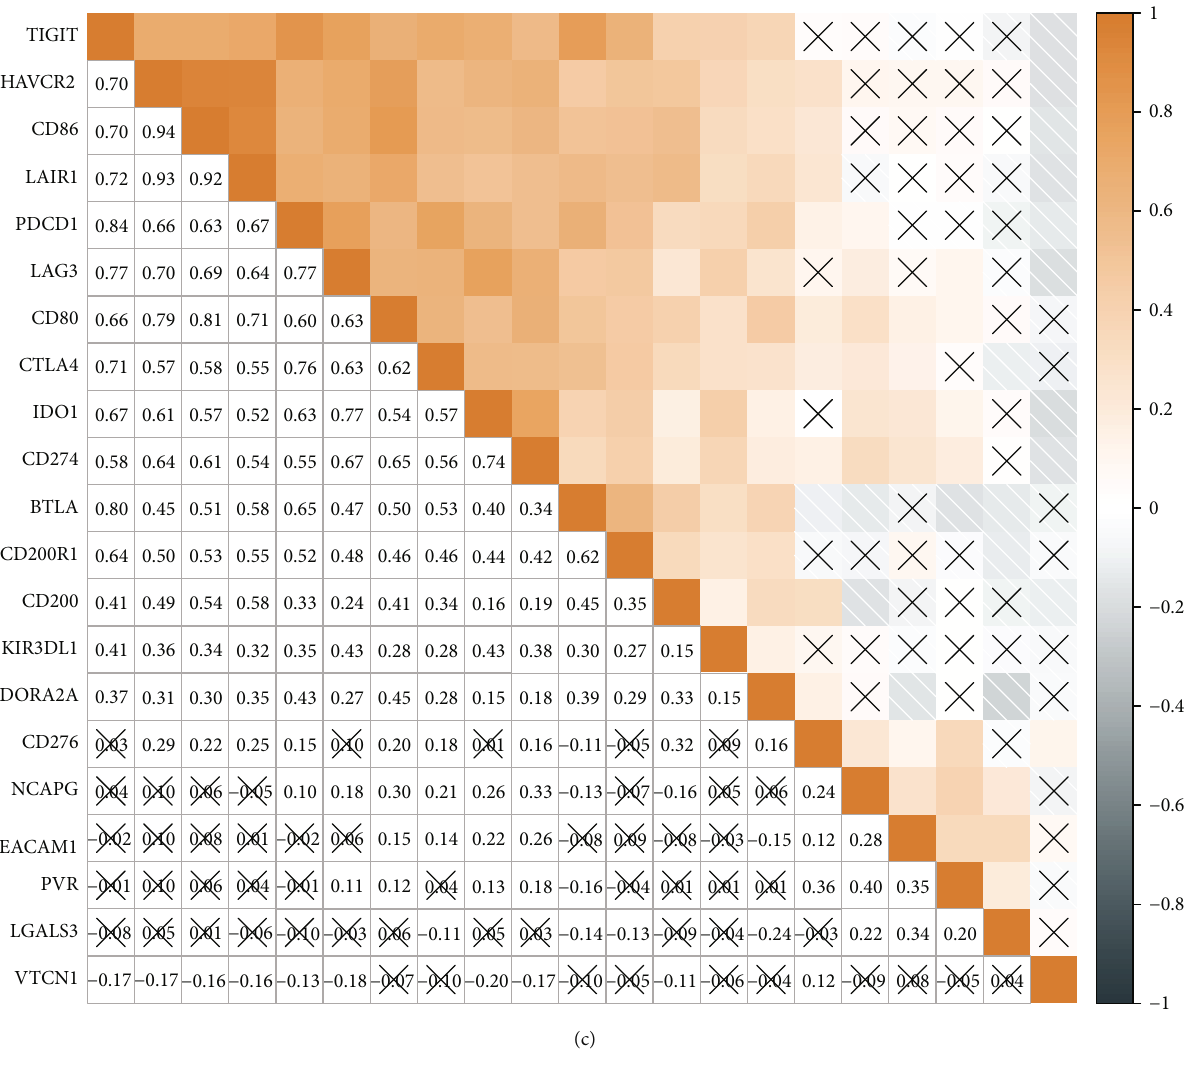
Figure 5: Di ff erences in the distribution of immune cell scores between NCAPG subgroups. (a) Di ff erences in immune cell scores between the high and low NCAPG groups. (b) Di ff erences in fi ve e ff ector genes among fi ve TIICs (CD8+ T cells, NK cells, macrophages, Th1 cells, and dendritic cells) between the high and low NCAPG groups. (c) Correlation between NCAPG and immune checkpoints. Colors and values indicate Spearman correlation coe ffi cients (X represents P > 0 : 05 ) ( ∗ , P < 0 : 05 ; ∗∗ , P < 0 : 01 ; ∗∗∗ , P < 0 : 001 ; ∗∗∗∗ , P < 0 : 0001 ; ns, P > 0 : 05